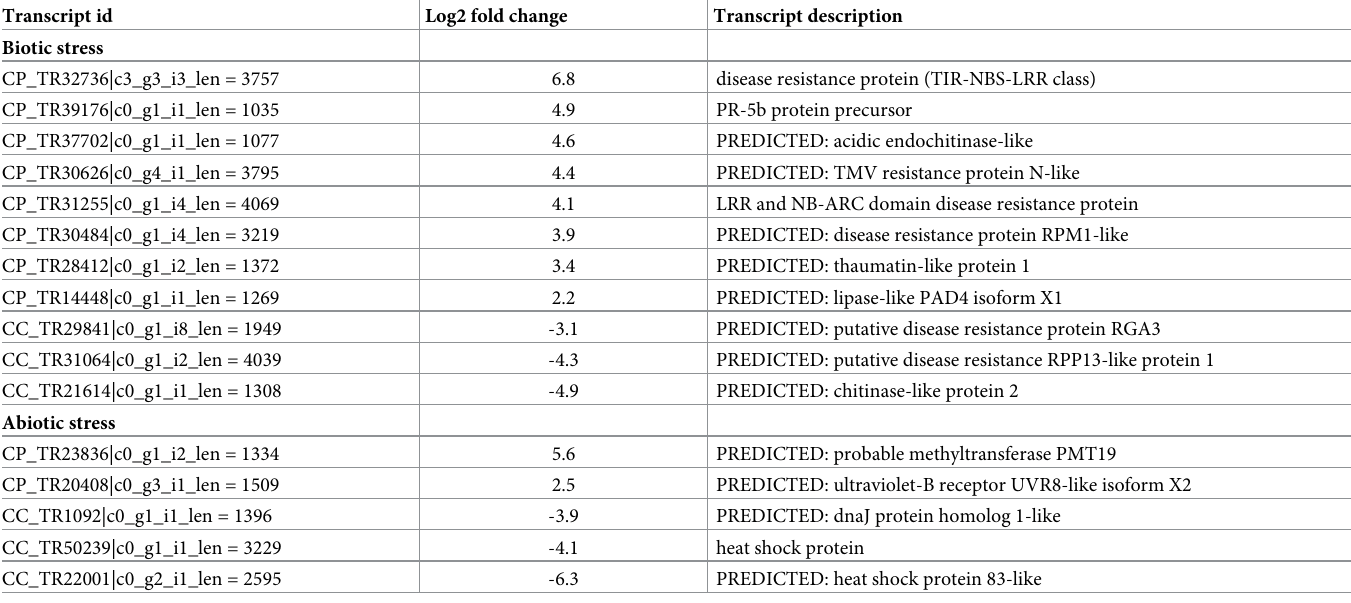
Table 4. Representative transcripts belonging to stress response genes differentially expressed in C . platycarpus compared to C . cajan . Transcript id Log2 fold